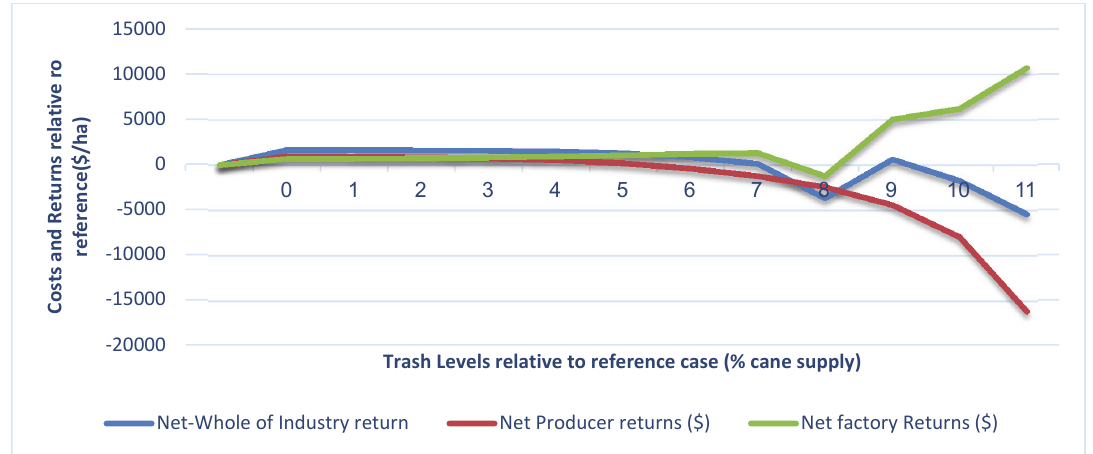
Fig. 6. The effect on Industry sector returns of changing levels of trash in the cane